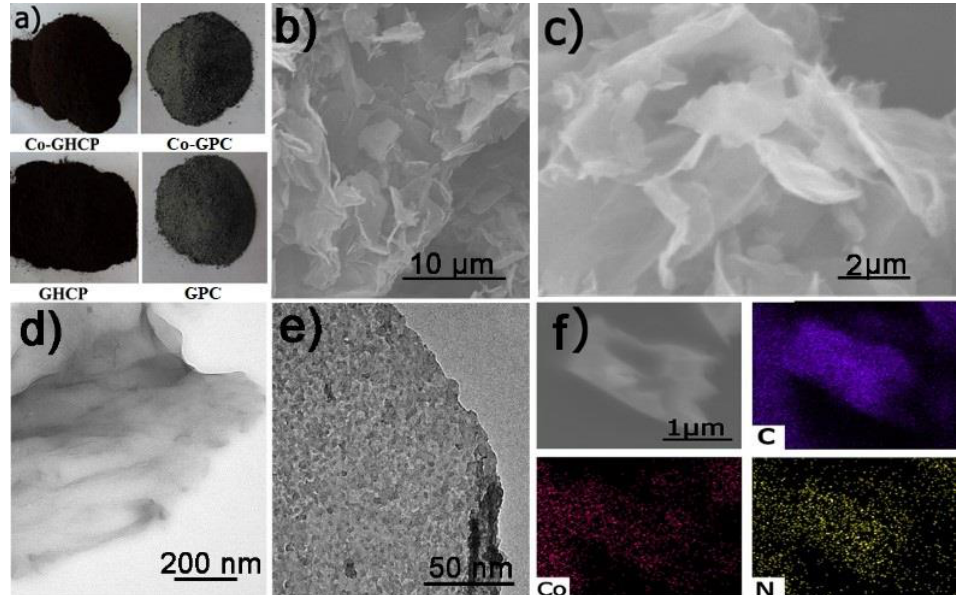
Figure 2. Morphology characterization of as-prepared nanosheets. ( a ) Co-GHCP, GHCP, Co-GPC and GPC. Scanning electron microscopy (SEM) ( b , c ), transmission electron microscopy (TEM) ( d , e ),